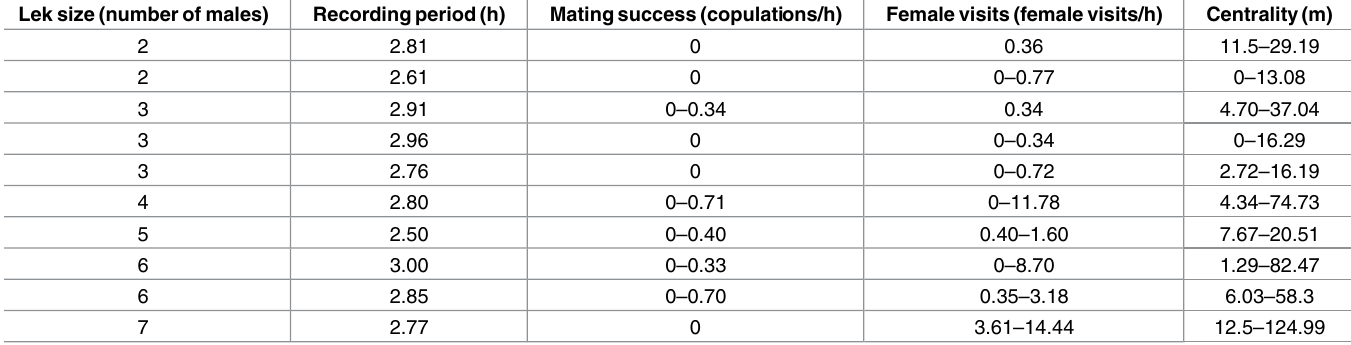
Table 1. Numberof residentmales,recording period and rangesof a) matingsuccessrate,b) femalevisits,and c) centralityof males at each of the 10 Manacusmanacus leks. Lek size (numberof